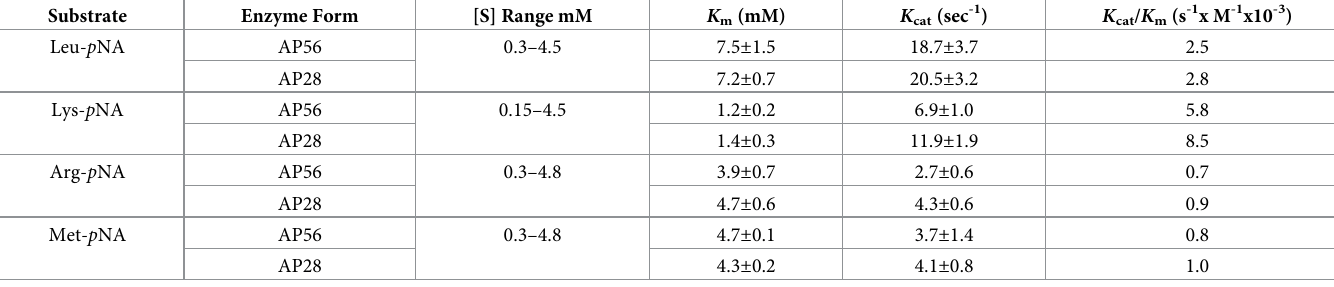
K m and V max values represent the mean ± SD of (at least) 4 independent